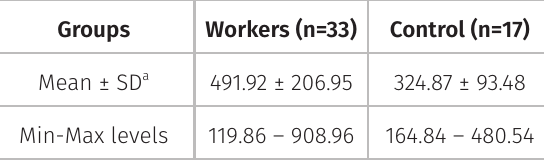
Table IV. Mean neopterin levels in urine samples (mmol neopterin/mol